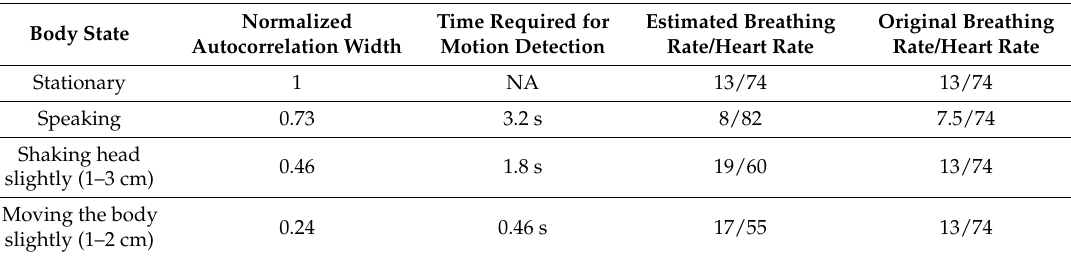
Table 4. Vital Signs during different motion states of the body.